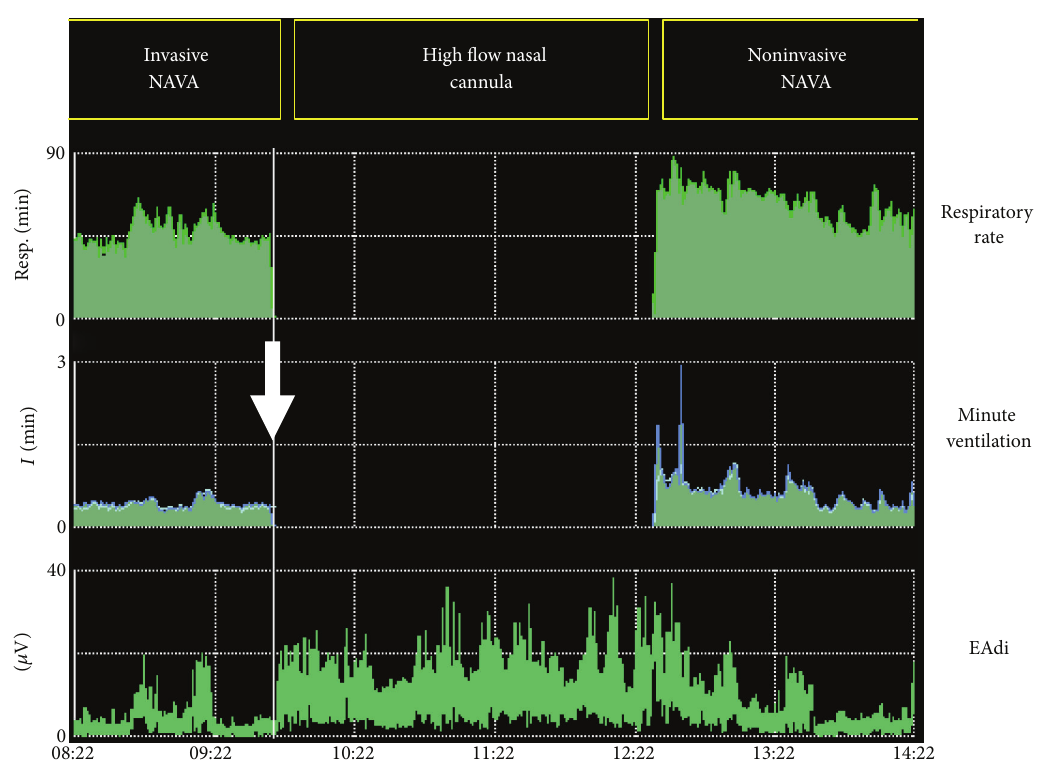
Figure 3: Evolution of respiratory rate, minute ventilation, and EAdi in a 15-day-old girl in the postoperative period of aortic valvotomy. After extubation (arrow), the infant was immediately supported with high flow nasal cannula. Progressive respiratory failure led to the introduction of noninvasive ventilation with NAVA 3 hours after extubation. An increase in EAdi was evident shortly after extubation, prior to the onset of clinical respiratory distress. The improvement of the respiratory failure with noninvasive ventilation was rapidly followed by a decrease in EAdi, toward preextubation levels.